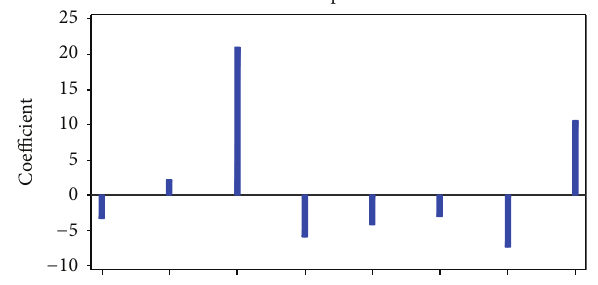
Table 7: Fitted models and model performance of TN and TP